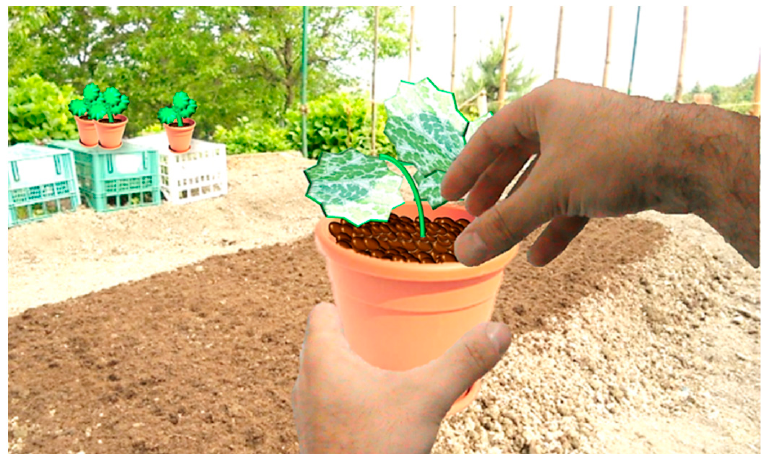
Figure 1. Example of a VR scenario showing how to take out the plant from the pot.